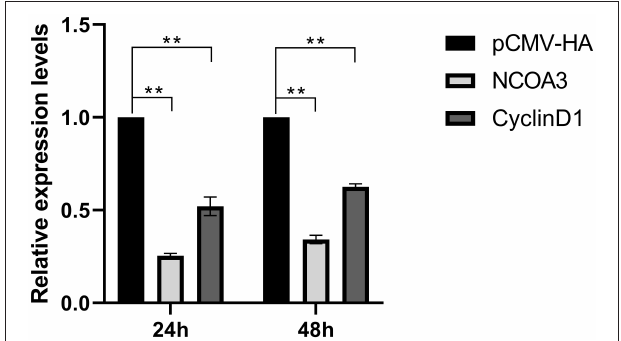
FIGURE 8 | At post-transfection of pCMV-TA-V1, cells were collected at 24 and 48h, respectively. The expression levels of NCOA3 and CyclinD1 were detected, respectively, by qPCR. ** p <